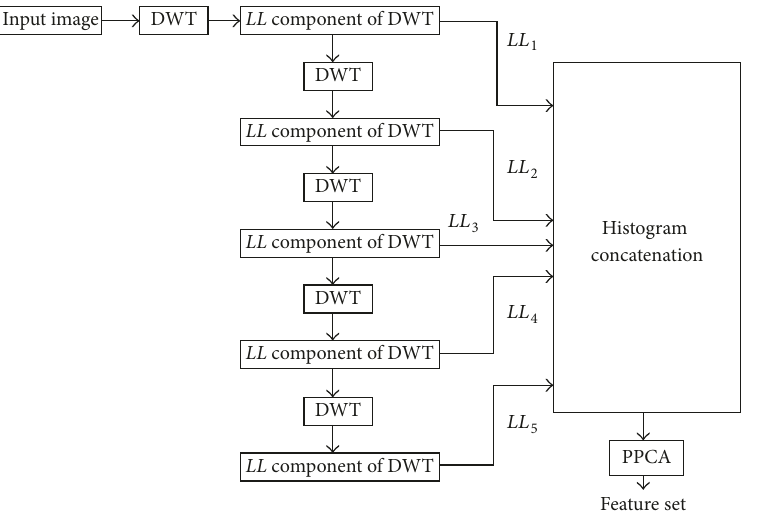
Figure 2: Schematic representation of the proposed